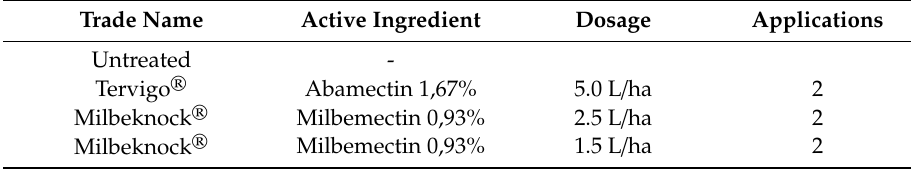
Table 4. Treatments applied to soil infested with Meloidogyne incognita in field